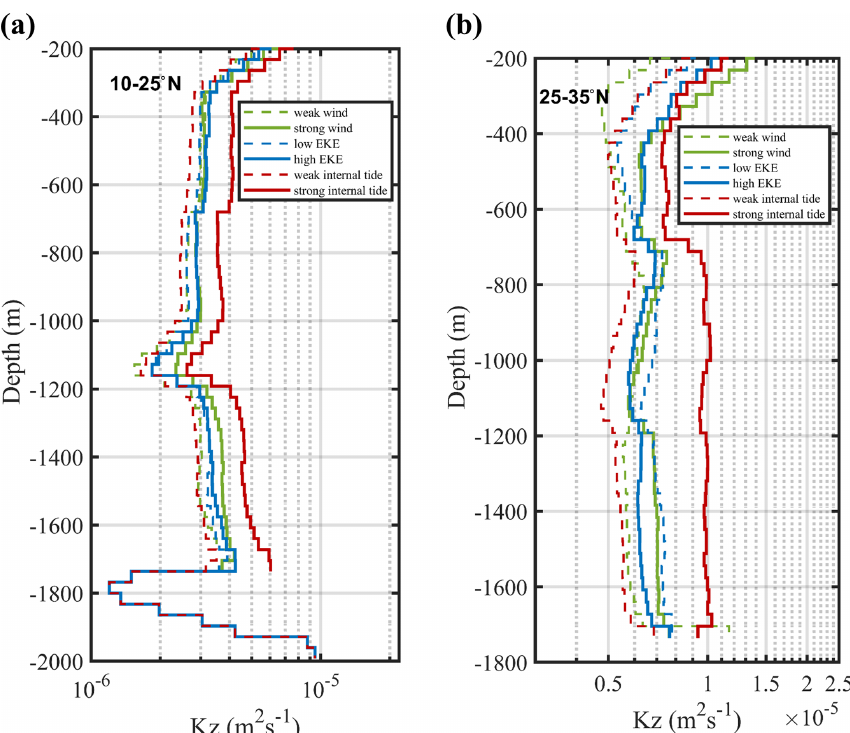
Figure 5. Vertical structures of geometric averaged diapycnal diffusivities K z with weak and strong wind (green), low and high EKE (blue), and weak and strong internal tides (red) in the (a) low latitude and (b) midlatitude.